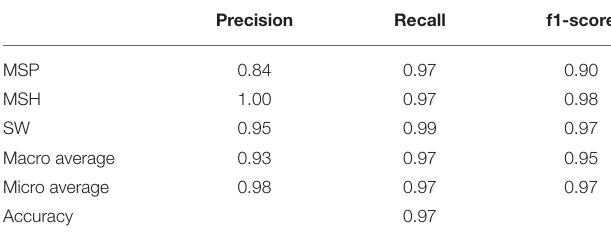
TABLE 5 | Classification report for FCN computed on the Cluster